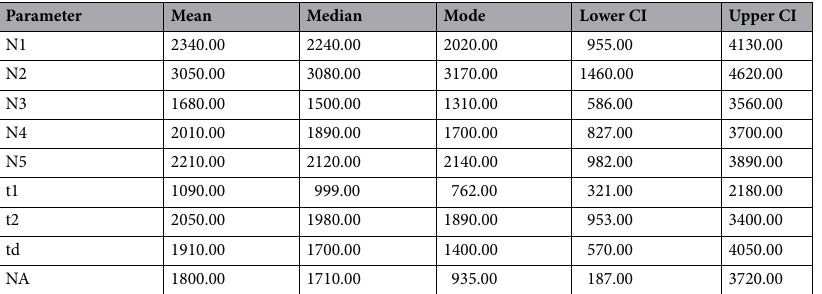
Table 5. Estimated divergence parameters and their 95% confidence interval based on the logistic estimate of DIYABC for the best supported scenario 3. Scenario 3 represents an early divergence of both the Seychelles and Madagascar populations with a more recent divergence of both the Aldabra population (from Madagascar) and the coastal East Africa group (Kenya and MCA), as shown in Fig. 5. N#: Effective population size; t#: time scale measured in number of generations. Numbers N1-N5 refer respectively to populations KEN, MOZ2, ALD2, MAD2 and SEY, with NA as ancestral population; t1 and t2 refer to increasingly older events, with td as oldest